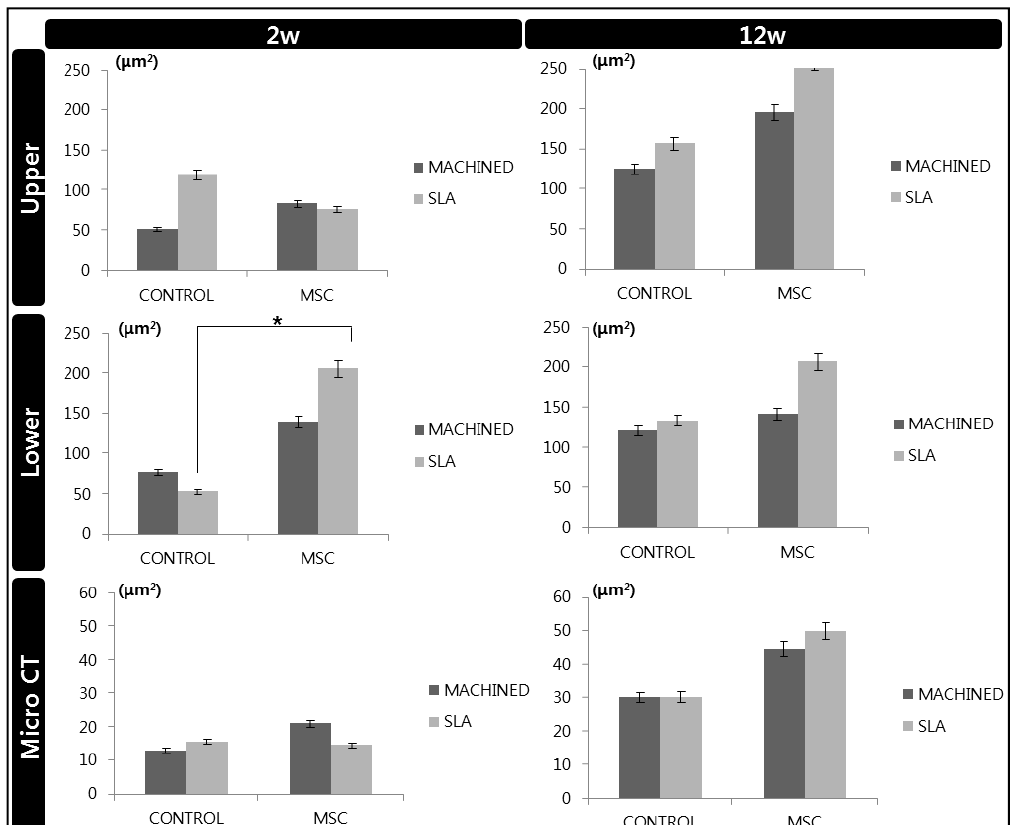
Figure 6. Newly formed bone (upper and lower) measured from X-ray images and within ROI from micro CT images. *: p < 0.05.